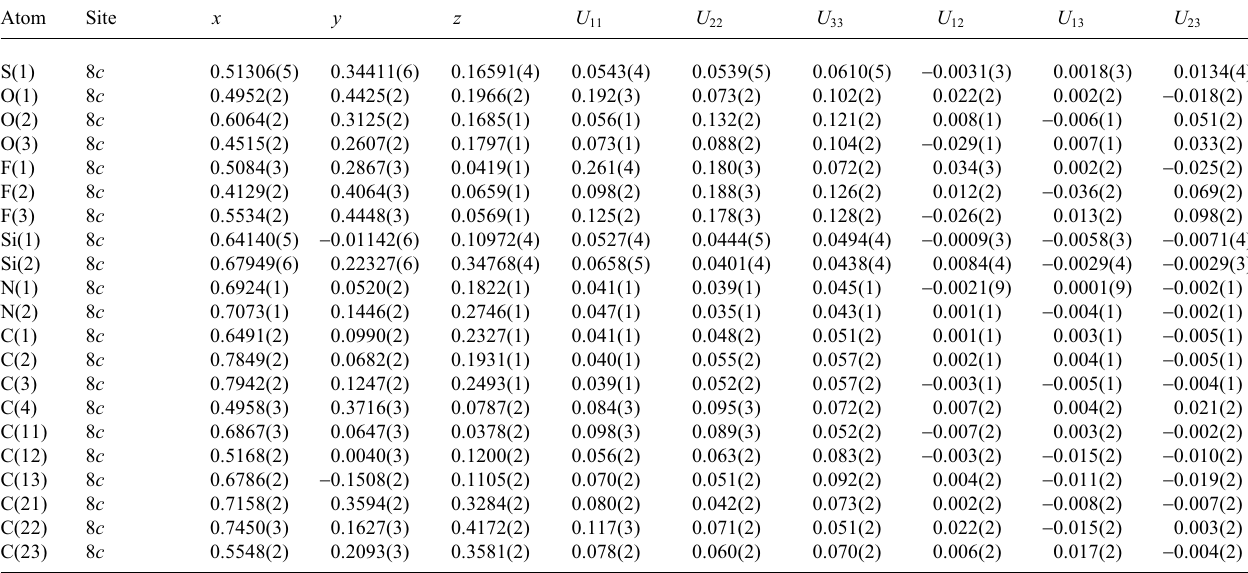
Table 3. Atomic coordinates and displacement parameters (in Å 2